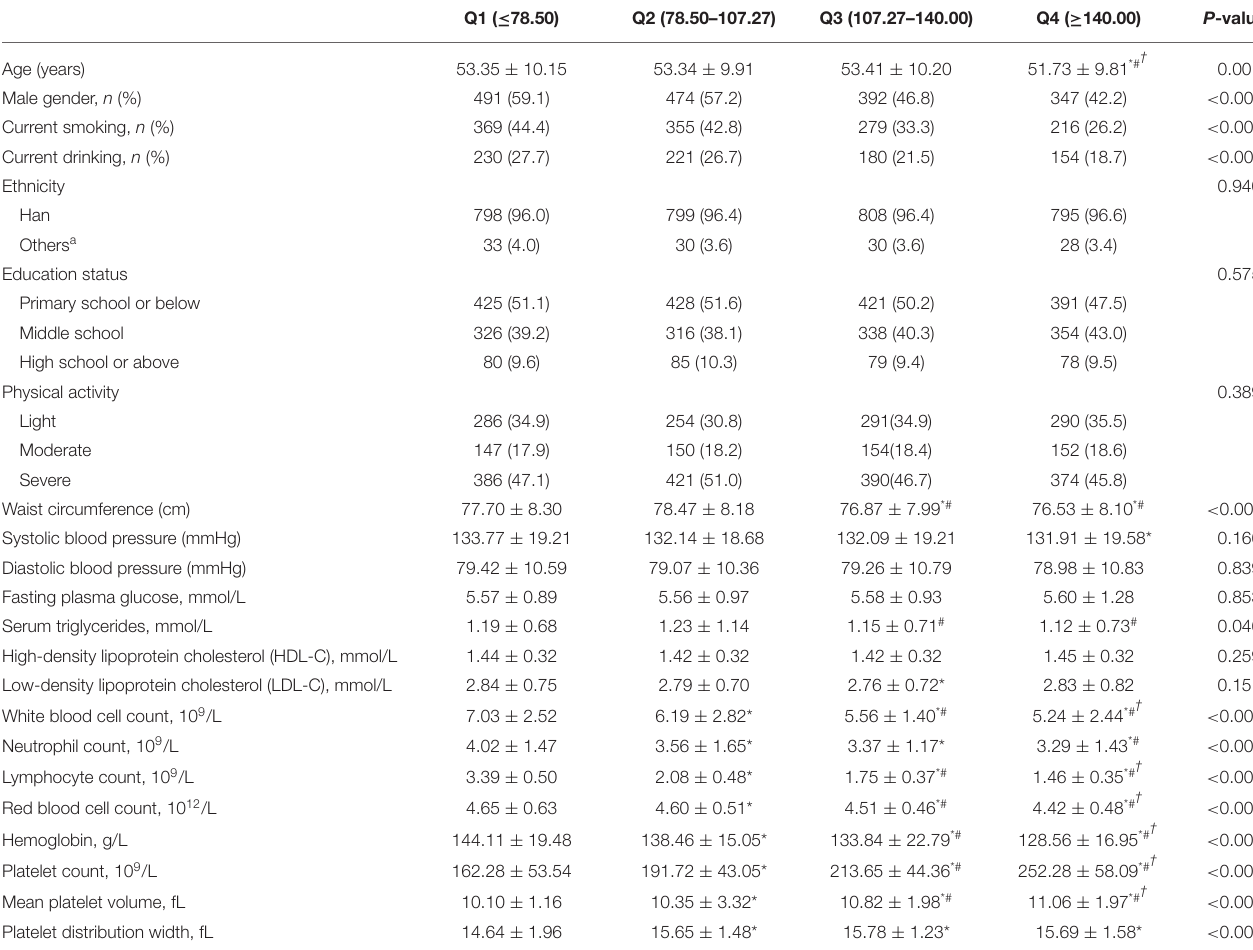
TABLE 2 | Characters of subjects according to quartile of platelet to lymphocyte ratio.